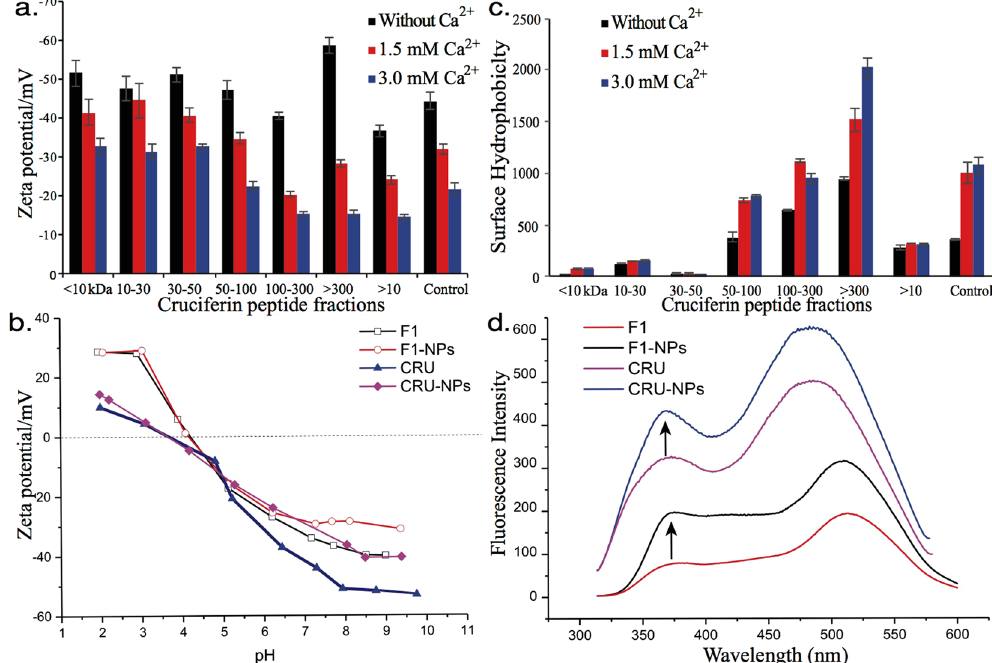
Figure 1. Changes in the ( a ) zeta potential and ( c ) surface hydrophobicity of cruciferin peptide fractions (Control was unfractionated sample). ( b ) Zeta potential of CRU (cruciferin peptides), F1 (cruciferin peptide fraction < 10 kDa), CRU-NPs (nanoparticles formed from cruciferin peptides), and F1-NPs (nanoparticles formed from cruciferin peptide fraction < 10 kDa) as a function of pH. ( d ) Intrinsic emission fluorescence spectra (excitation wavelength: 295 nm, slit: 10 nm) of CRU, F1, CRU-NPs, and